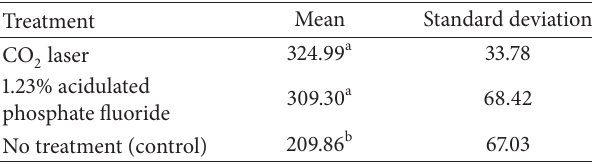
Table 1: Microhardness values (mean and standard deviation) according to the superficial treatments in different experimental groups ( 𝑃 = 0.03